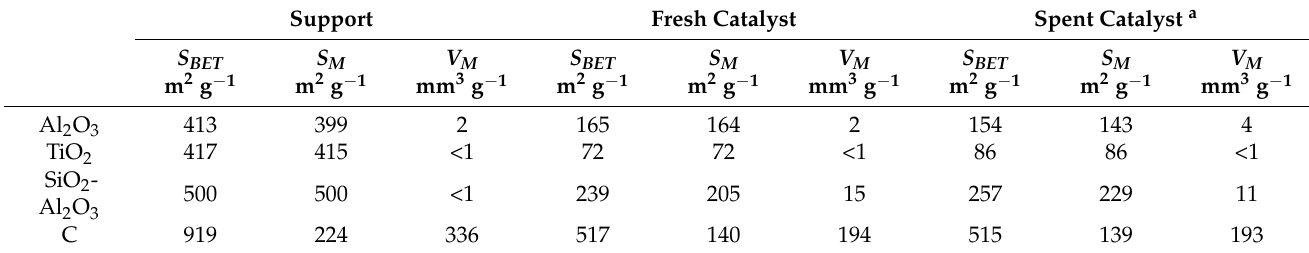
Table 2. The comparison of specific surface area S BET with mesopore surface area S M and volume of micropores V M normalized per gram of sample ( S M and V M calculated by t -plot